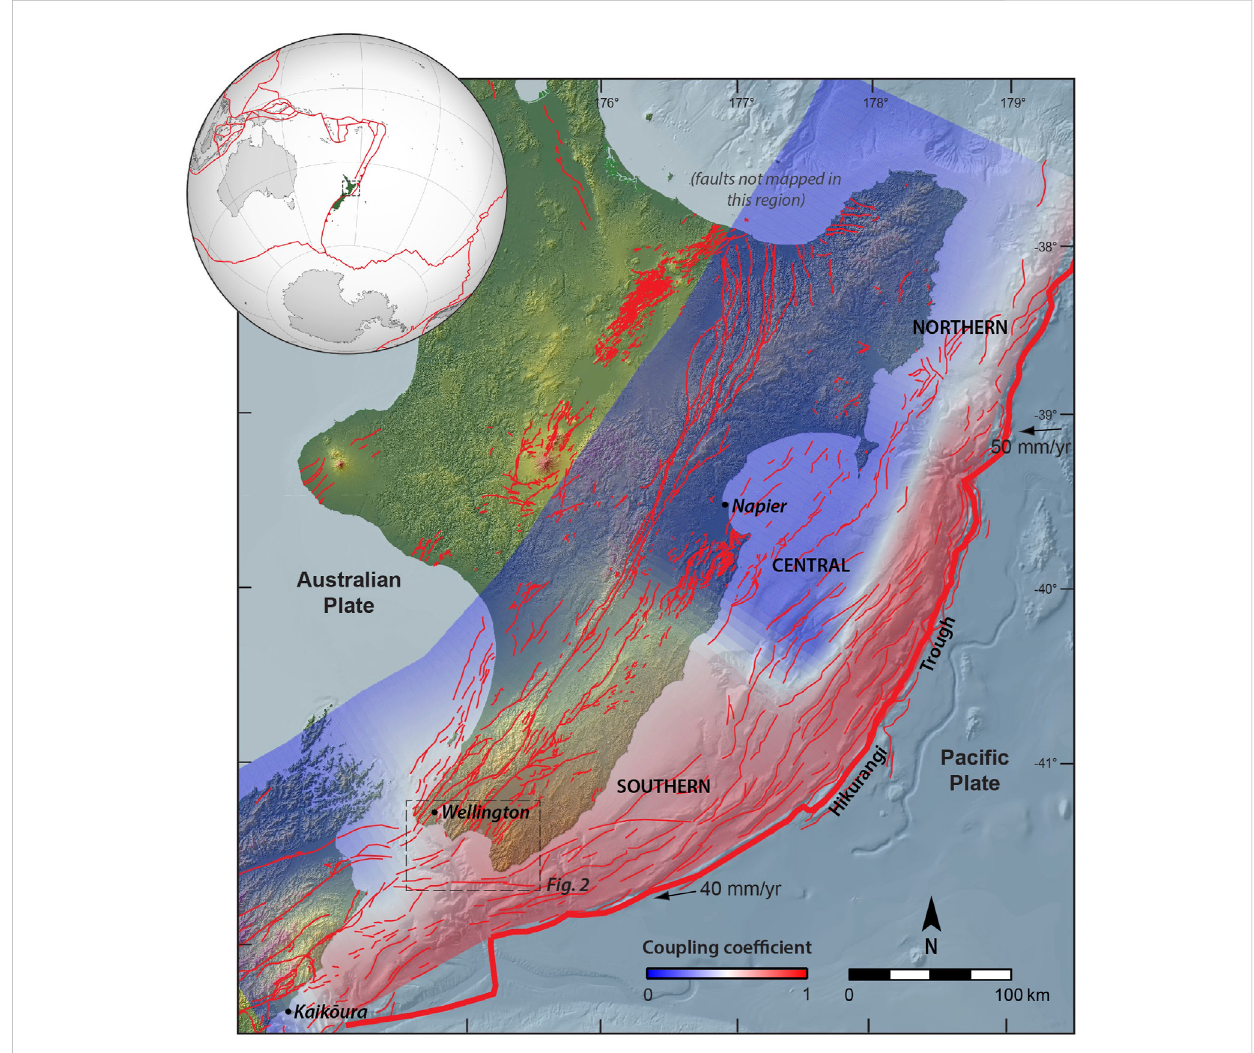
FIGURE 1 Tectonic setting of New Zealand showing plate boundary components and motion rates (DeMets et al., 1990; DeMets et al., 1994; DeMets et al., 2010),andHikurangisubductioninterfacecouplingoftheNorthIsland-regionsinblueareweaklycoupled(undergoingaseismicslowslip),regionsinred are fully elastically coupled (locked) (from Wallace et al., 2012). Also shown are active crustal faults (red lines) (onshore faults from the New Zealand CommunityFaultModel(NZCFM)-Seebecketal.,2022;offshoreactivefaultsfromBarnesandAudru,1999;Barnesetal.,2002;Nodderetal.,2007; Mountjoy et al., 2009; Barnes et al., 2010; Pondard and Barnes, 2010; Mountjoy and Barnes, 2011; Barnes et al., 2019; Litch fi eld et al.,